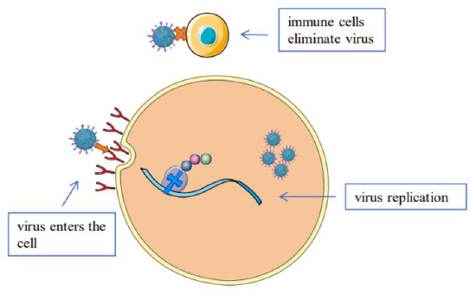
Figure 2. Antiviral mechanism of medicinal fungi in vivo.